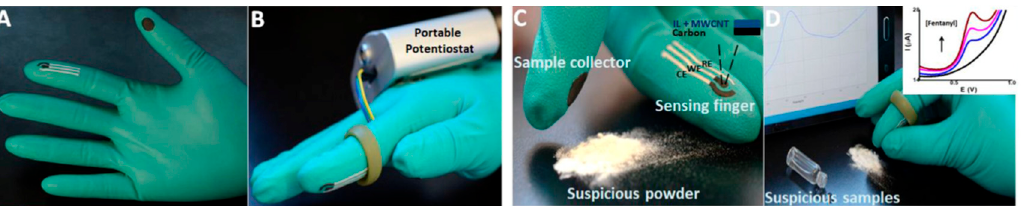
Figure 5. Overview of the lab-on-a-glove device for on-site electrochemical detection of fentanyl; ( A ) glove containing SPE on the sensing index finger and sample collector pad on the thumb. ( B ) The glove-based sensor with a portable electroanalyzer–potentiostat. ( C ) Collecting a powdery sample. ( D ) Joining of collecting (thumb) and sensing (index) fingers after swiping a powder sample to start SWV scans [51]. Reused with permission from Elsevier.